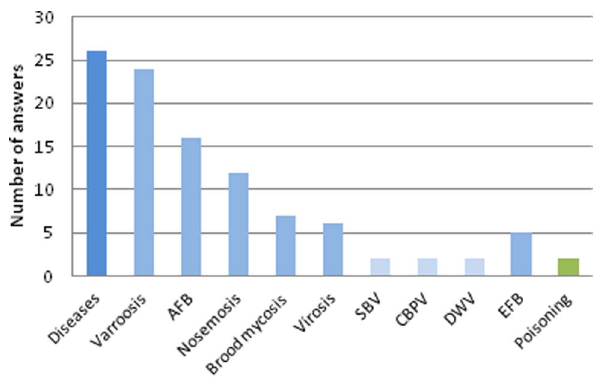
Figure 3. Main diseases observed in the field in Europe, in 2010. Diseases: non-specified diseases AFB: American foulbrood, SBV: Sacbrood virus, CBPV: Chronic bee paralysis virus, DWV: Deformed wing virus, EFB: European foulbrood.